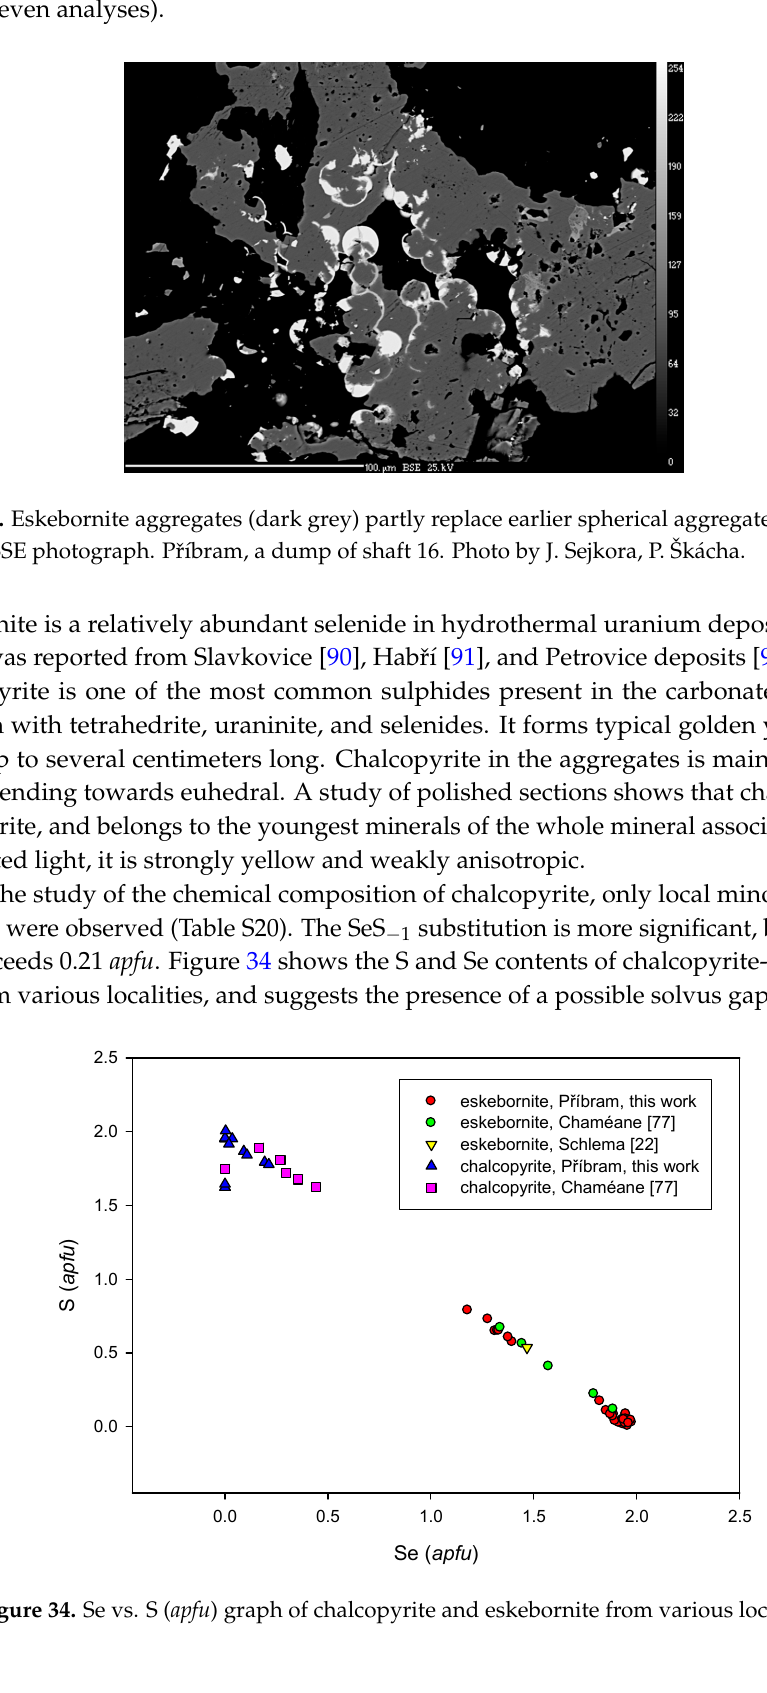
Figure 32. Eskebornite grains (dark grey) in hakite aggregates (light grey). BSE photograph. P ř íbram, a dump of shaft 16. Photo by J. Sejkora, P. Škácha.